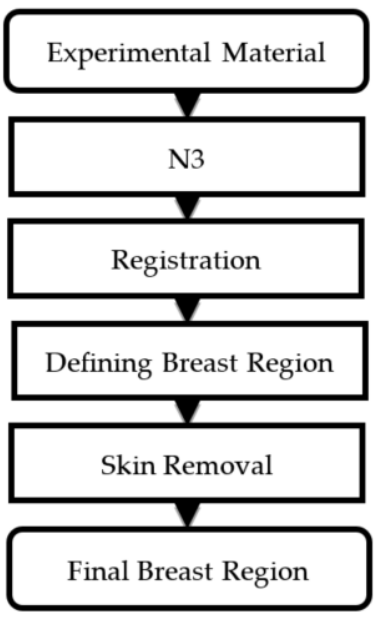
Figure 2. Flow chart showing image pre-processing steps.